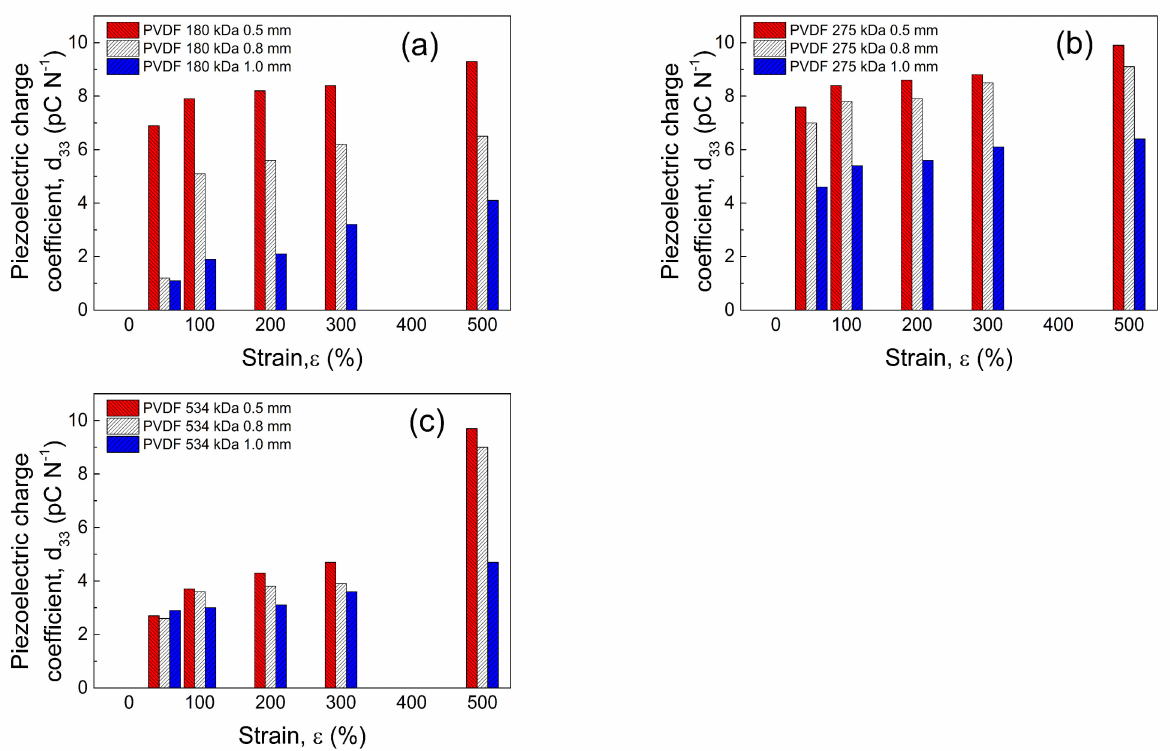
Figure 4. d 33 piezoelectric constant identification at various strain deformations for PVDF samples of different molecular weights and initial thicknesses. 180 kDa ( a ), 275 kDa ( b ) and 534 kDa ( c